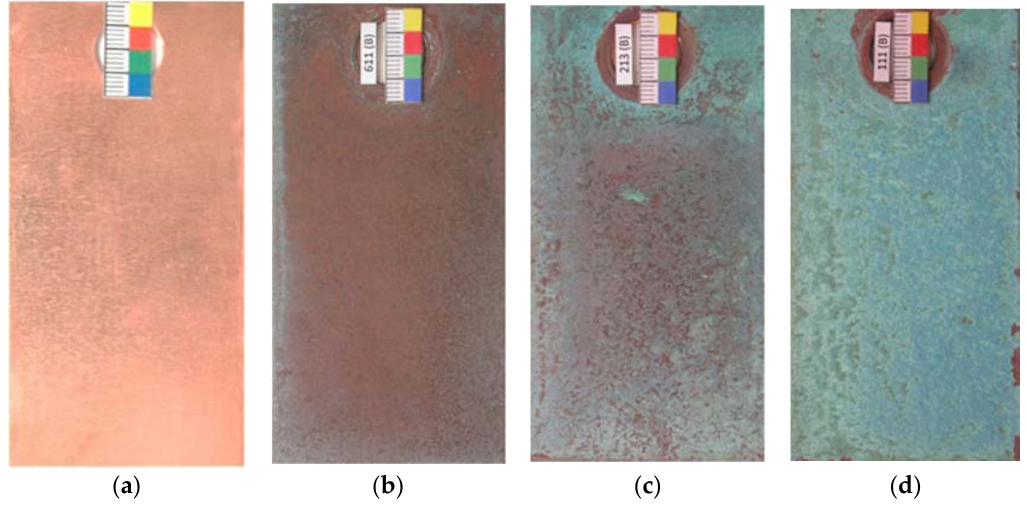
Figure 5. Overview of color changes in the patina formed on copper when exposed to marine atmospheres. ( a ) Initial salmon pink; ( b ) reddish tone corresponding to cuprite, ( c , d ) turquoise blue coloring corresponding to basic copper chlorides formed on cuprite.